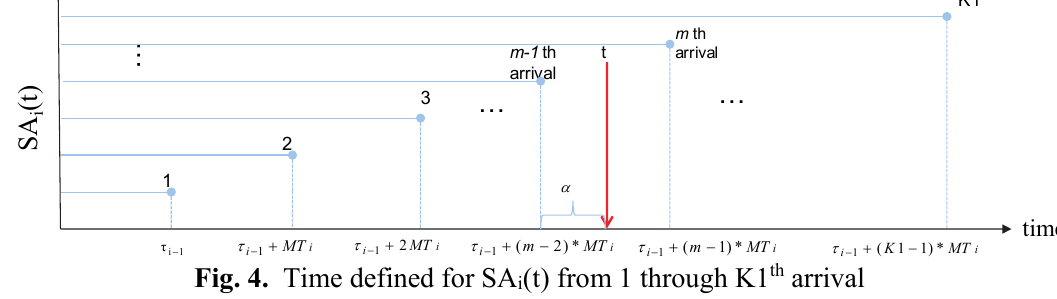
Fig. 4. Time defined for SA i (t) from 1 through K1 th